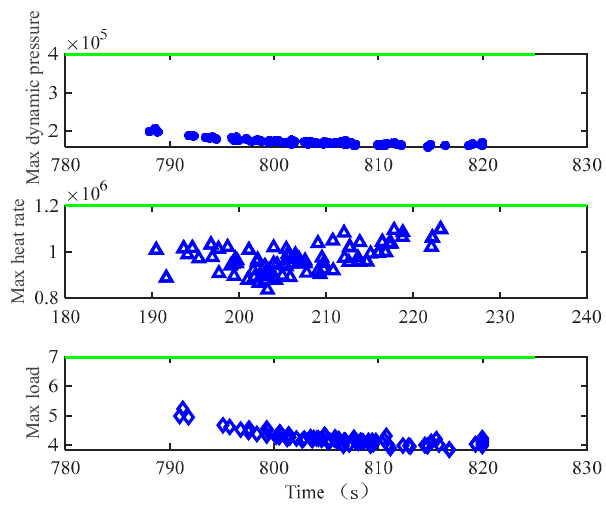
Figure 31. Path constraint maximum distribution.